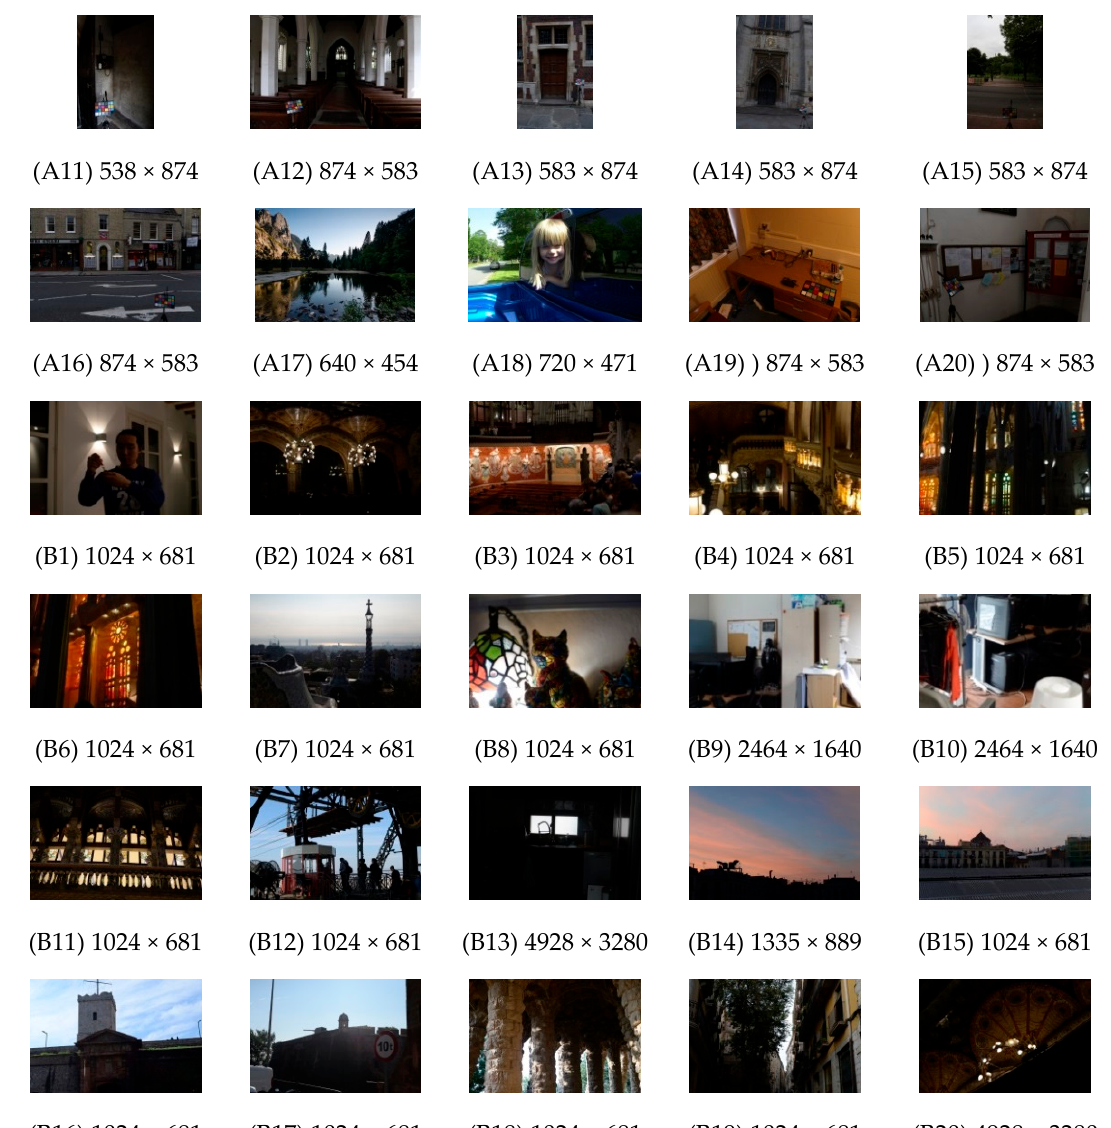
Figure 3. Test images used in the experiments.